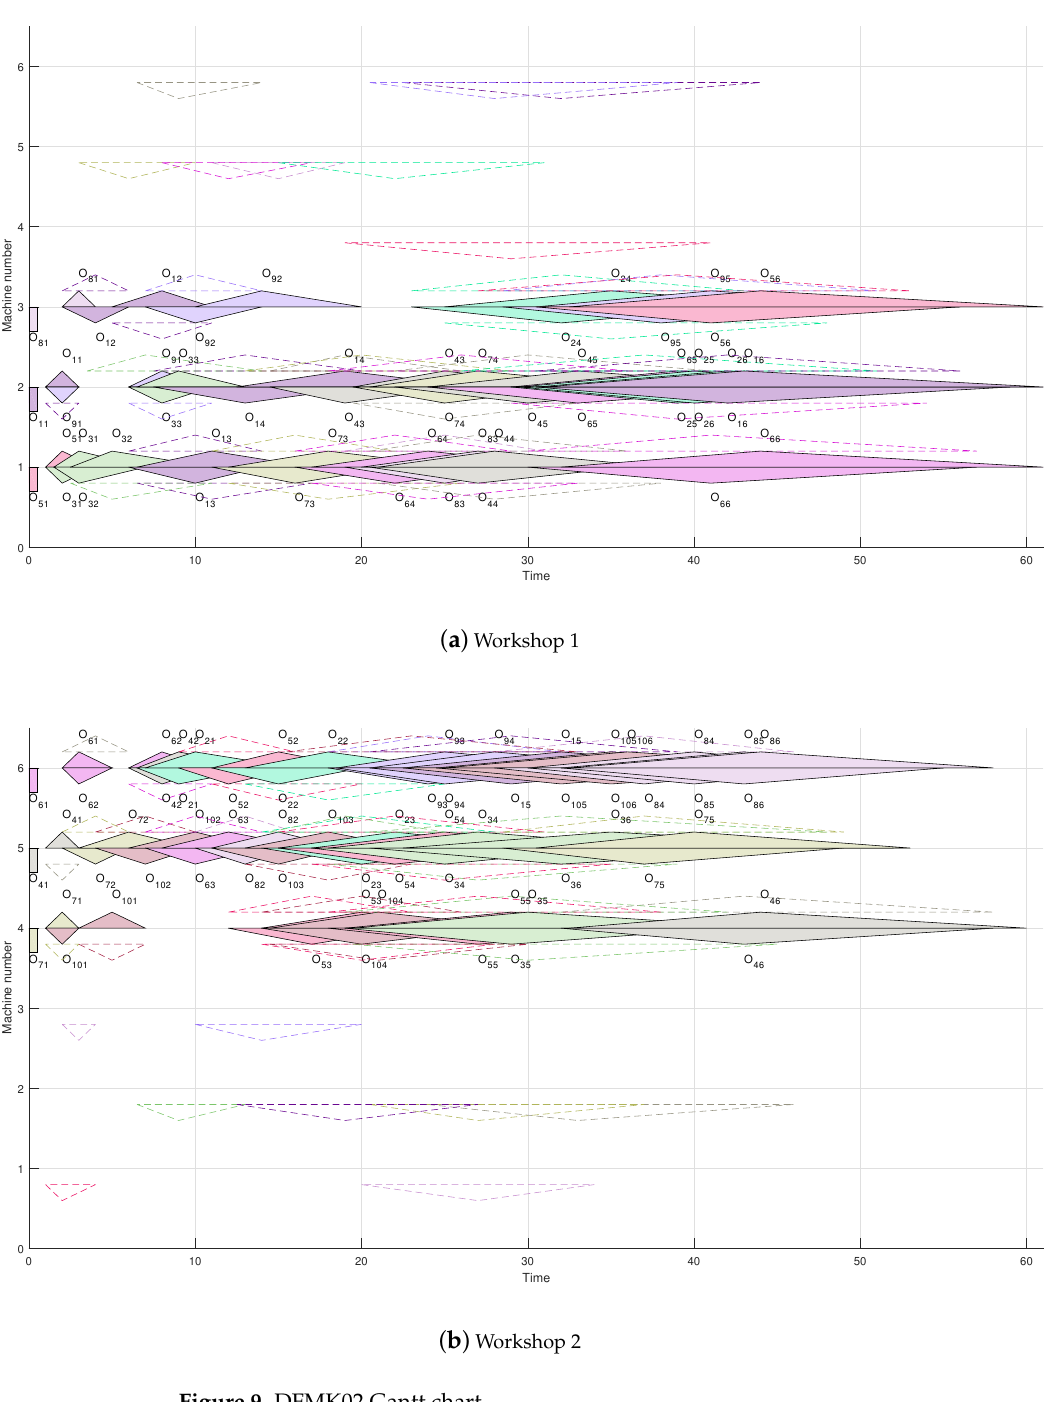
Figure 9. DFMK02 Gantt